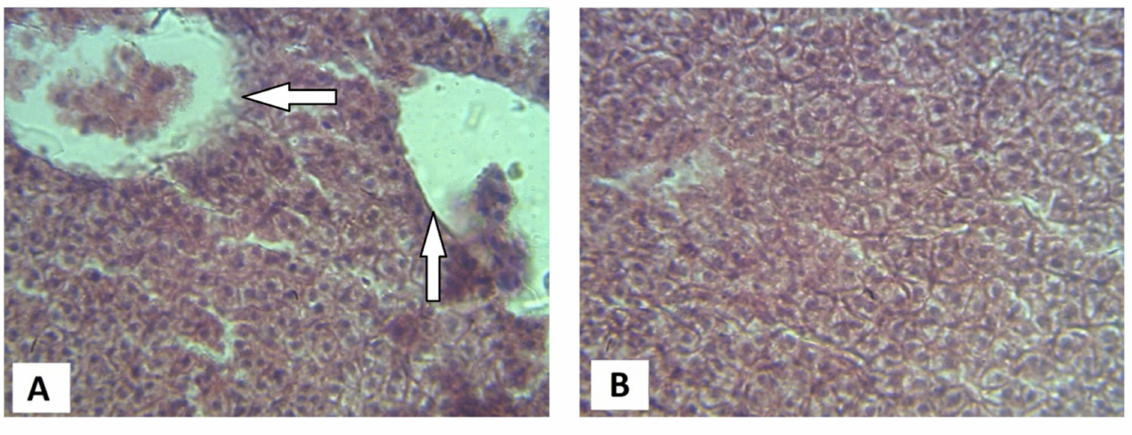
Figure 2. Microsection of the Liver of African catfish C. gariepinus fed inclusion of ( A ) raw J. curcas kernel; ( B ) and 72 h socked J. curcas kernel (arrows show portions of sloughed/necrotic liver